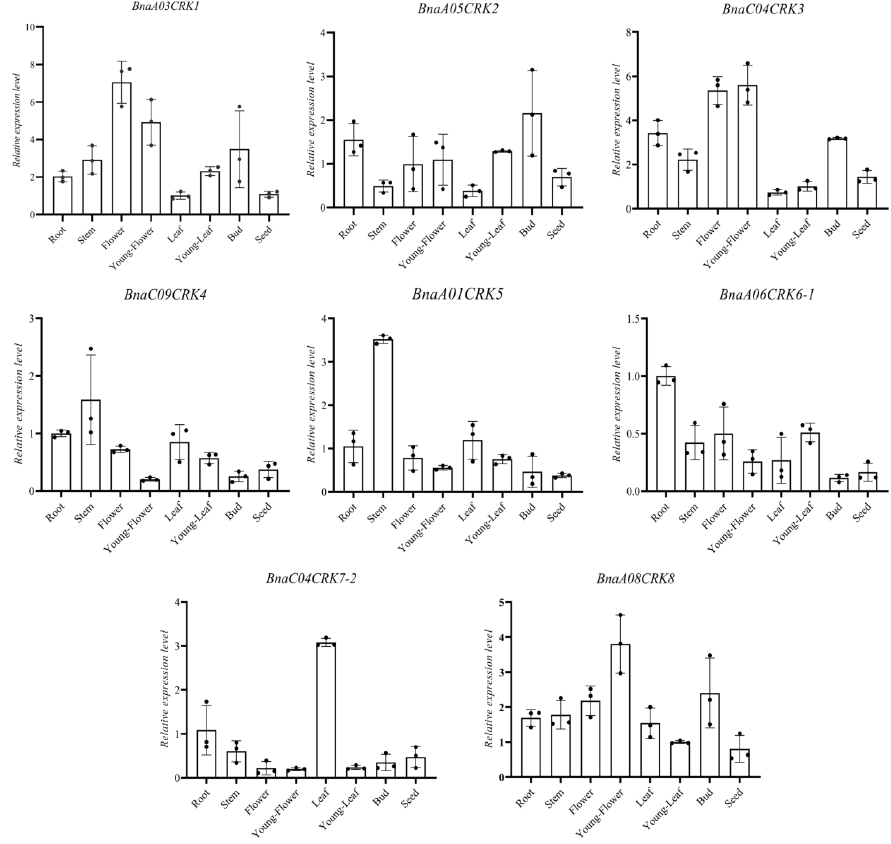
Figure 7. Tissue expression profile of the candidate BnaCRKs . The B. napus Actin (gene ID: XM013858992) was used to adjust the expression level of the selected BnaCRKs . The x-axis shows the name of the tissues. The error bars on the y-axis represent the data from qRT-PCR, which is the mean of three biological and technical replicates (Table S7.2).